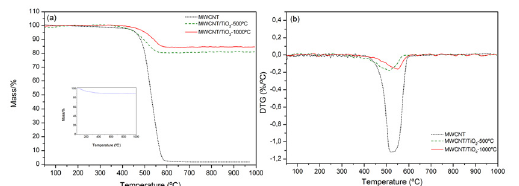
Figure 5.. Thermogravimetric analysis (a) and DTG (b) of MWCNT and TiO -coated MWCNT, calcined at 500 and 1000°C. The inset in 2 (a) is TGA curve of MWCNT/TiO performed in argon up to 1000ºC 2 just before running the TGA analysis in an oxidizing atmosphere, for the TiO -coated MWCNT sample calcined at 2